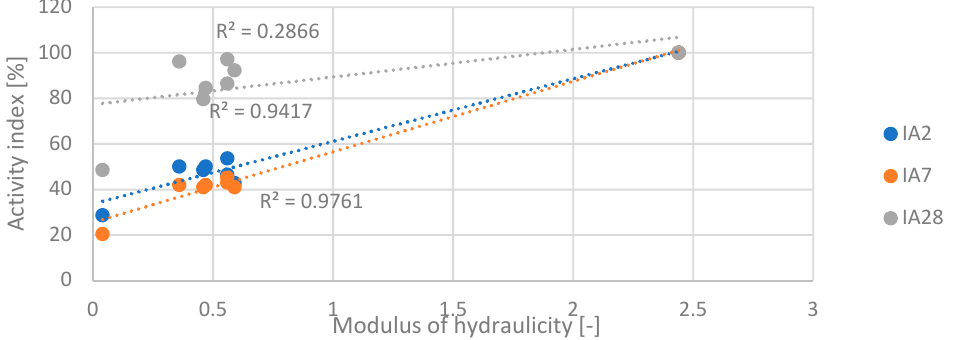
Figure 2. Dependence between modulus of hydraulicity and activity indexes calculated in 2, 7, and 28